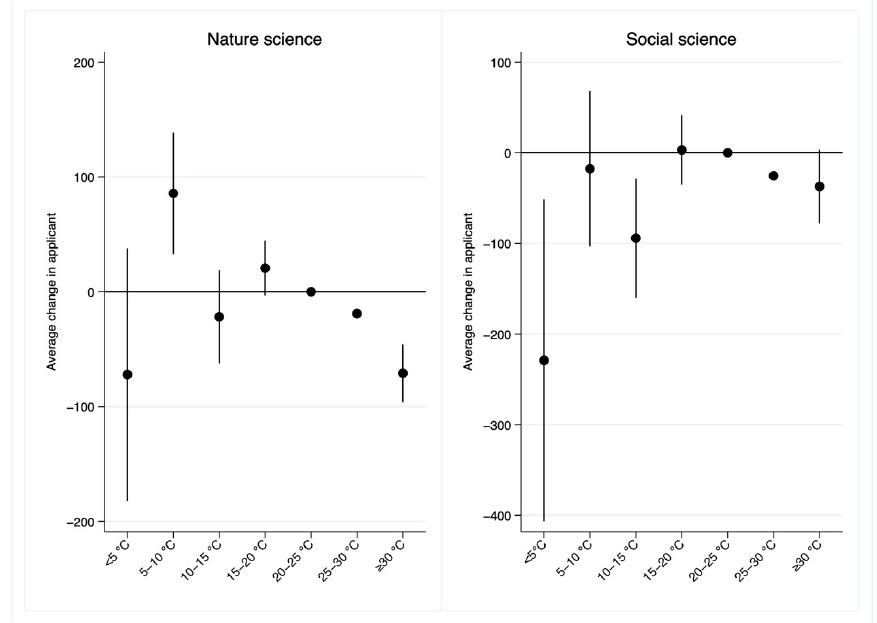
Figure 6. Estimated impacts of temperature on the number of applicants for the UNGEE by disci- pline category.